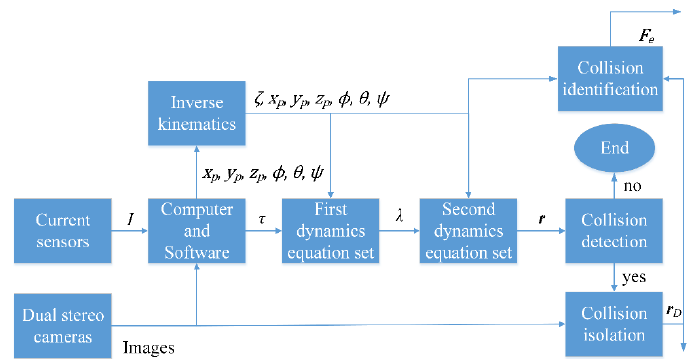
Figure 7. The block diagram of the collision problems solving process.